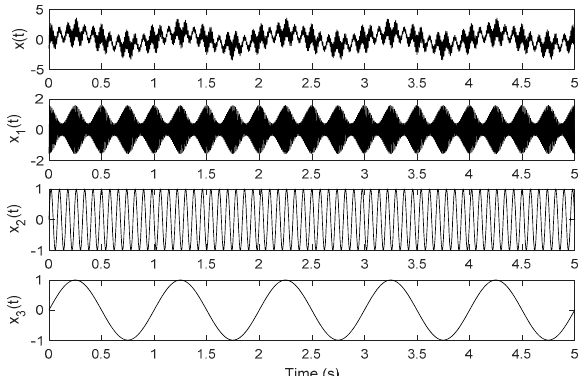
Figure 1. Time domain waveform of the simulation signal x ( t ) and its components.